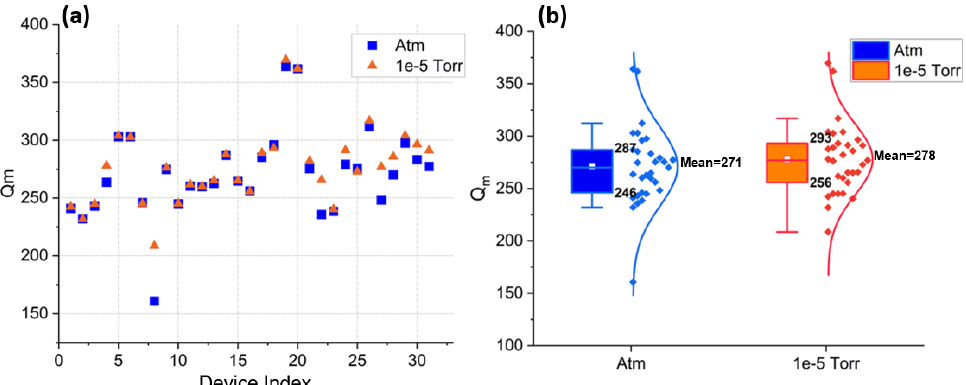
Figure 12. ( a ) Q m of 30 devices measured in air (atm) vs high vacuum (1 × 10 − 5 ). ( b ) The statistical summary of the Q m in air and in a vacuum is represented as boxes with length determined by 25% and 75% percentile and corresponding normal curve distribution.